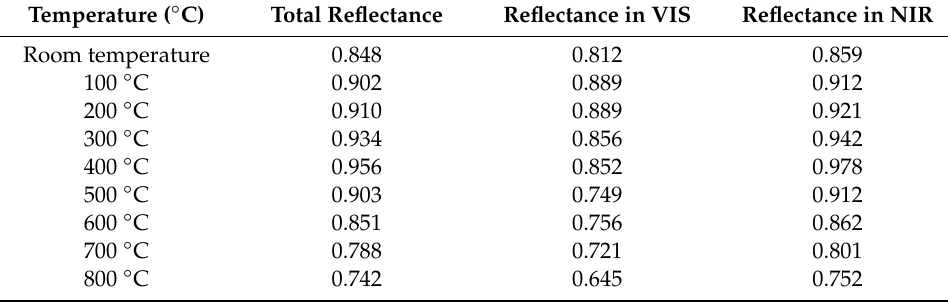
Figure 6. The reflectance of the shell powder calcined at different temperatures. Table 2. The reflectance of shell powder calcined at different temperatures.